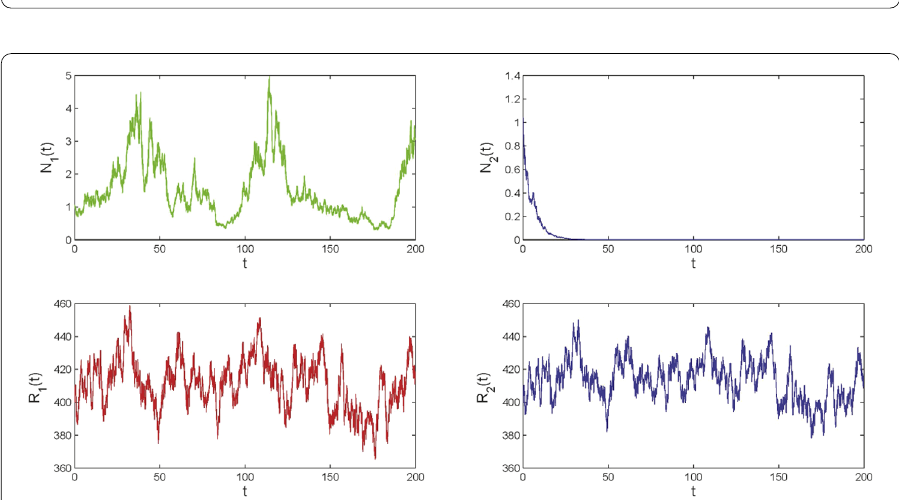
Figure 2 Time evolution of the system in Example 1 with initial condition (1,400) when m 1 = 0.325, m 2 =